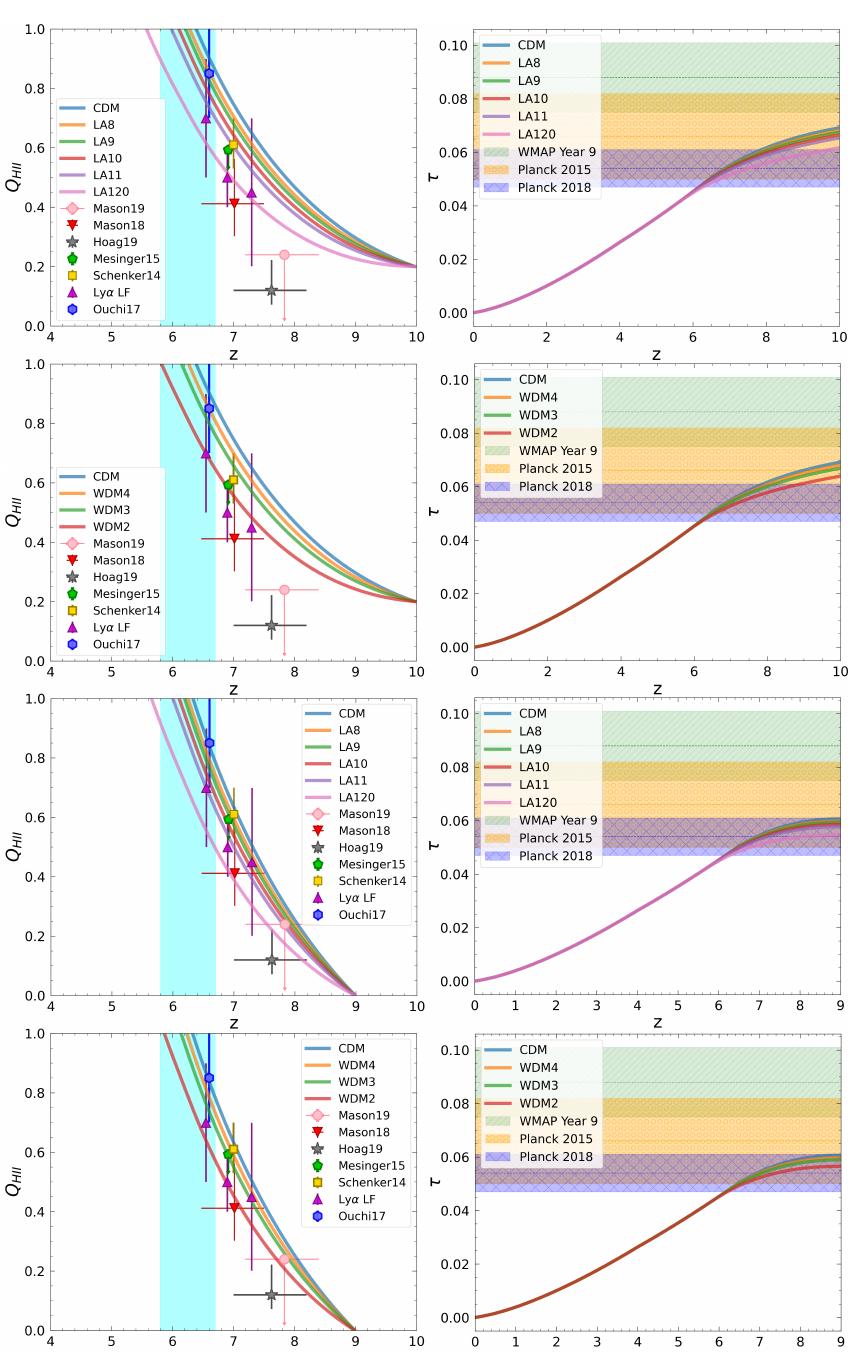
Figure 7. ( Left ): evolution of the filling fraction Q HII , for sterile neutrino and thermal WDM models, with log ( ξ ion / ( erg − 1 Hz )) = 25.2. The two upper panels have initial condition Q HII ( z = 10 ) = 0.2 and f esc = 0.05. The two lower panels are plotted with Q HII ( z = 9 ) = 0.0 and f esc = 0.06. The cyan shaded region indicates our fiducial late-Reionization redshift interval, 5.8 < z < 6.7. The upward triangle labelled Ly α LF includes results by Konno et al. (2014), Konno et al. (2017) and Zheng et al. (2017) [43–45]. ( Right ): electron scattering optical depth for different models, compared with measurements from Planck and WMAP